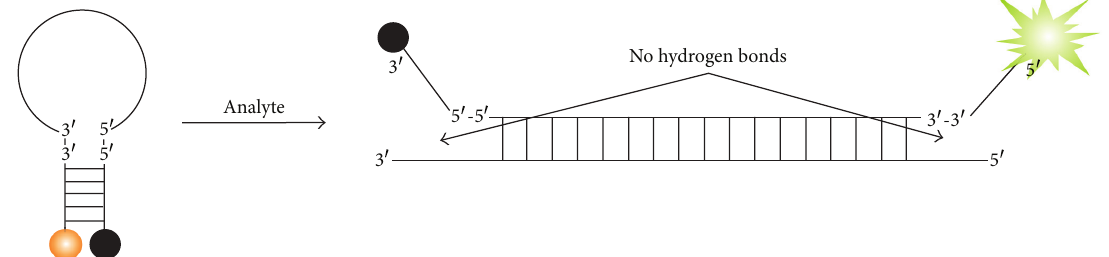
F 5: Hairpin inversion MB probes [100]. e terminal stem-forming sequences are connected by the 3 linkages (le). In complex with a target, the orientation of DNA strand in stem-forming fragments is the same as in the analyte, which eliminates a possibility of